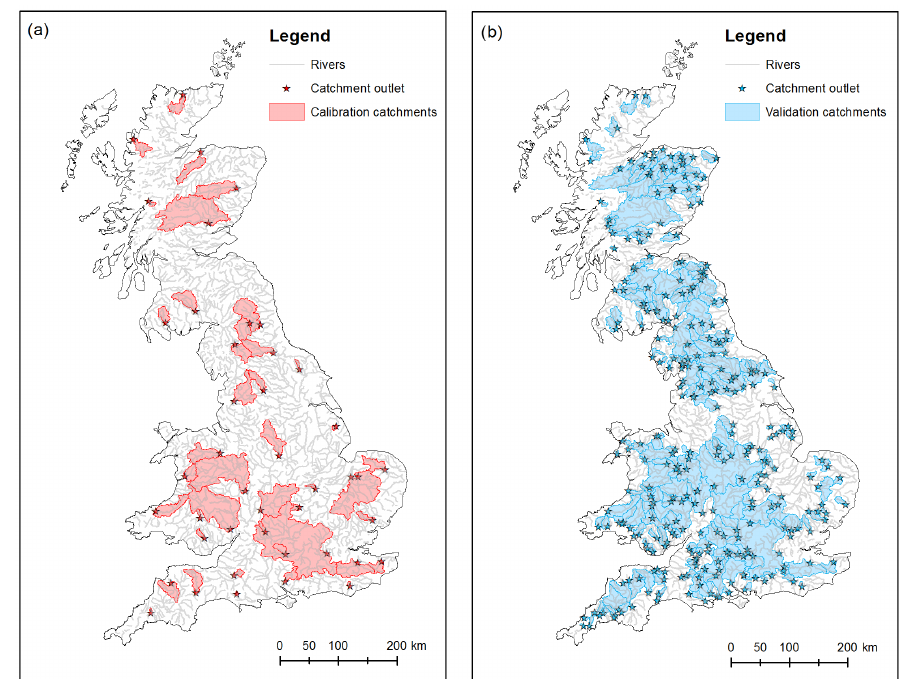
Figure 2. Maps of the boundaries and outlets of (a) catchments that were used to calibrate the PET equations and to calculate the performance metrics of the PET equations, described in Sect. 3.3.1 (stages 1, 2 and 3 in Fig. 1); and (b) catchments that were used to carry out the assessment of the final PET grids using the performance metrics described in Sect. 3.3.2 (stages 4 and 5 in Fig.